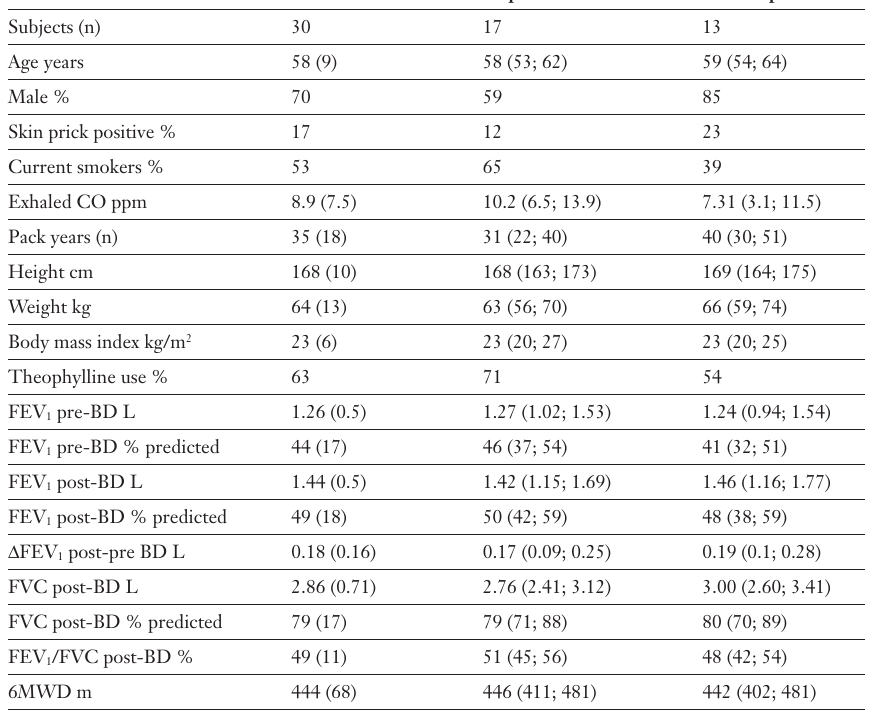
Table 1 Baseline characteris- tics of all patients, responders and non- responders, to oral corticosteroid trial. Values are mean (SD) for all patients and mean (95% confi- dence interval) for responders and non- responders or pro- portions expressed in percent. Ppm = parts per million; FEV 1 = forced expiratory volume in 1 second; FVC = forced vital capacity; BD = broncho- dilator; 6MWD = six- minute walk